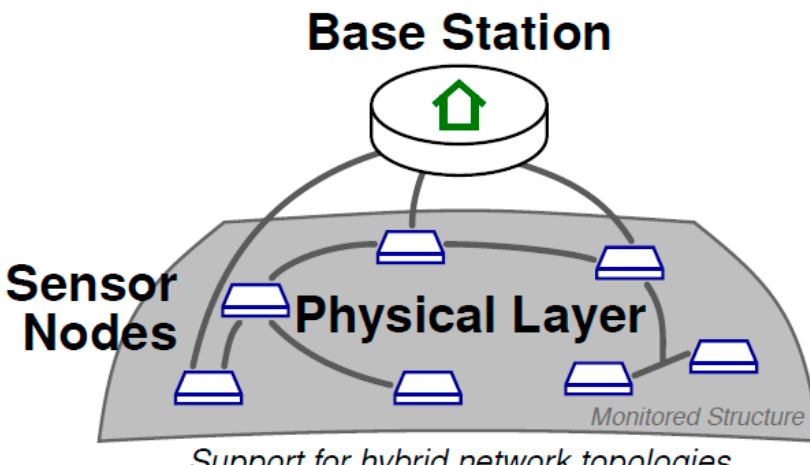
Figure 9. Graphical representation of a wired sensor network for SHM.